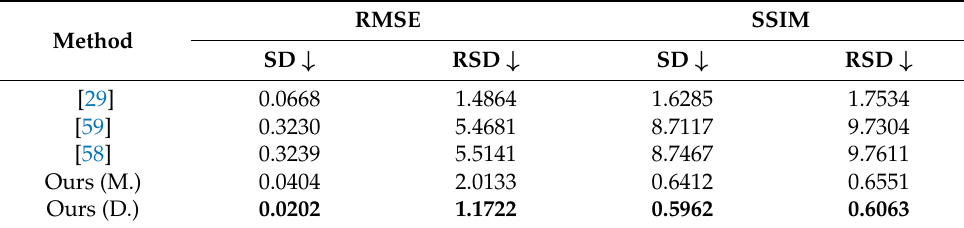
Table 2. Standard deviation and relative standard deviation of multi-view highlight